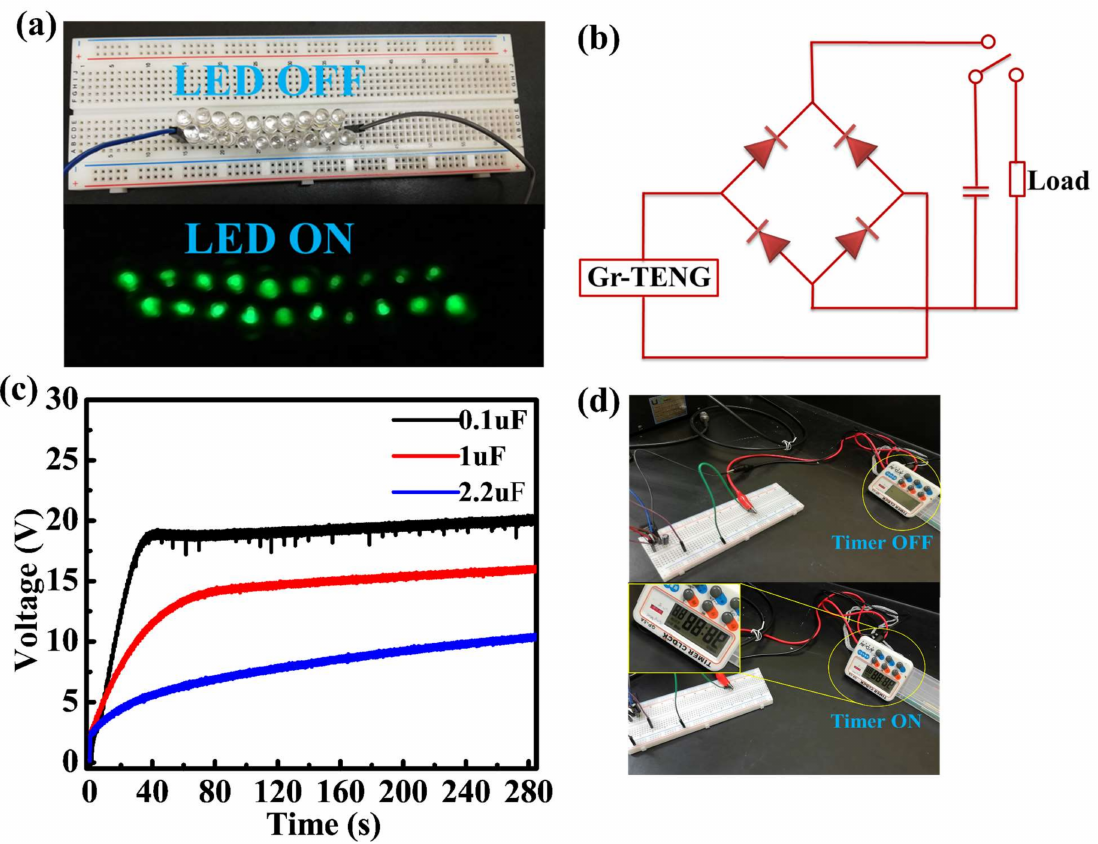
Figure 8. Applications of the Gr-TENG with Al 2 O 3 as the CTL as a power supply: ( a ) Photograph showing 20 green light-emitting diodes (LEDs) being powered. ( b ) Circuit diagram of the bridge-rectifier for charging a capacitor and turning on a timer. ( c ) Charging curves of capacitors with various capacitances (0.1, 1 and 2.2 µ F). ( d ) Photograph of powering a